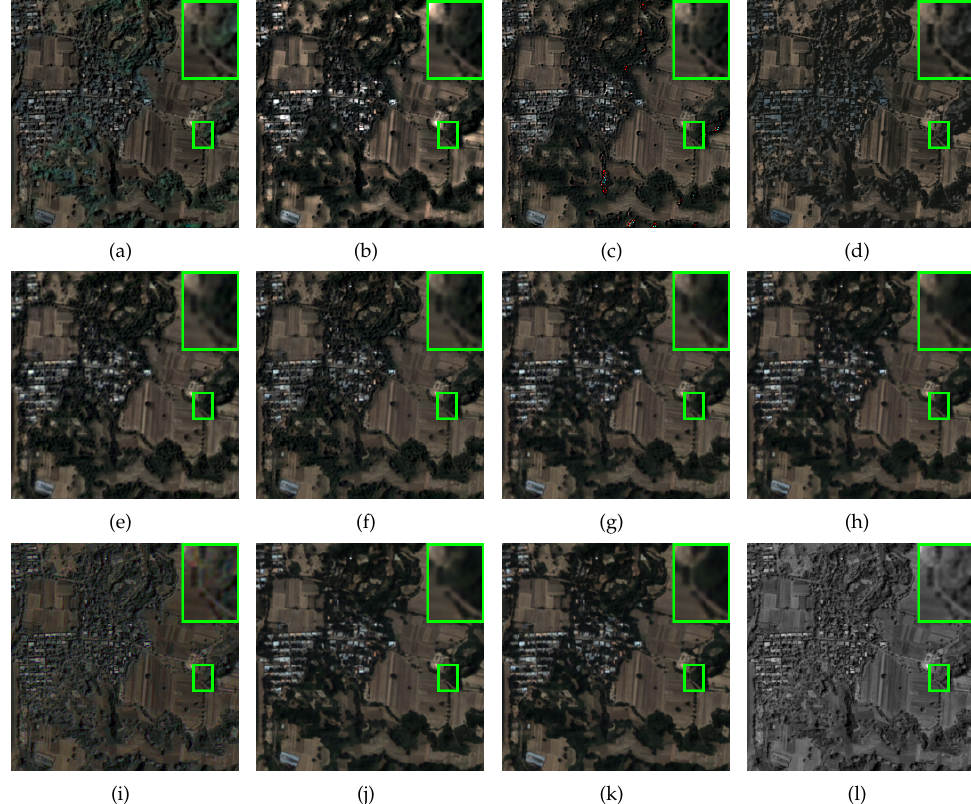
Figure 8. Qualitative comparison of MPFINet with ten counterparts on a typical satellite image pair from the QB dataset at full resolution. The enlarged view of the corresponding region is shown in the green box. ( a ) Brovey. ( b ) MTF_GLP_HPM. ( c ) SFIM. ( d ) CNMF. ( e ) PNN. ( f ) PANNET. ( g ) SRPPNN. ( h ) MUCNN. ( i ) ZeRGAN. ( j ) PanFormer. ( k ) MPFINet (ours). ( l )